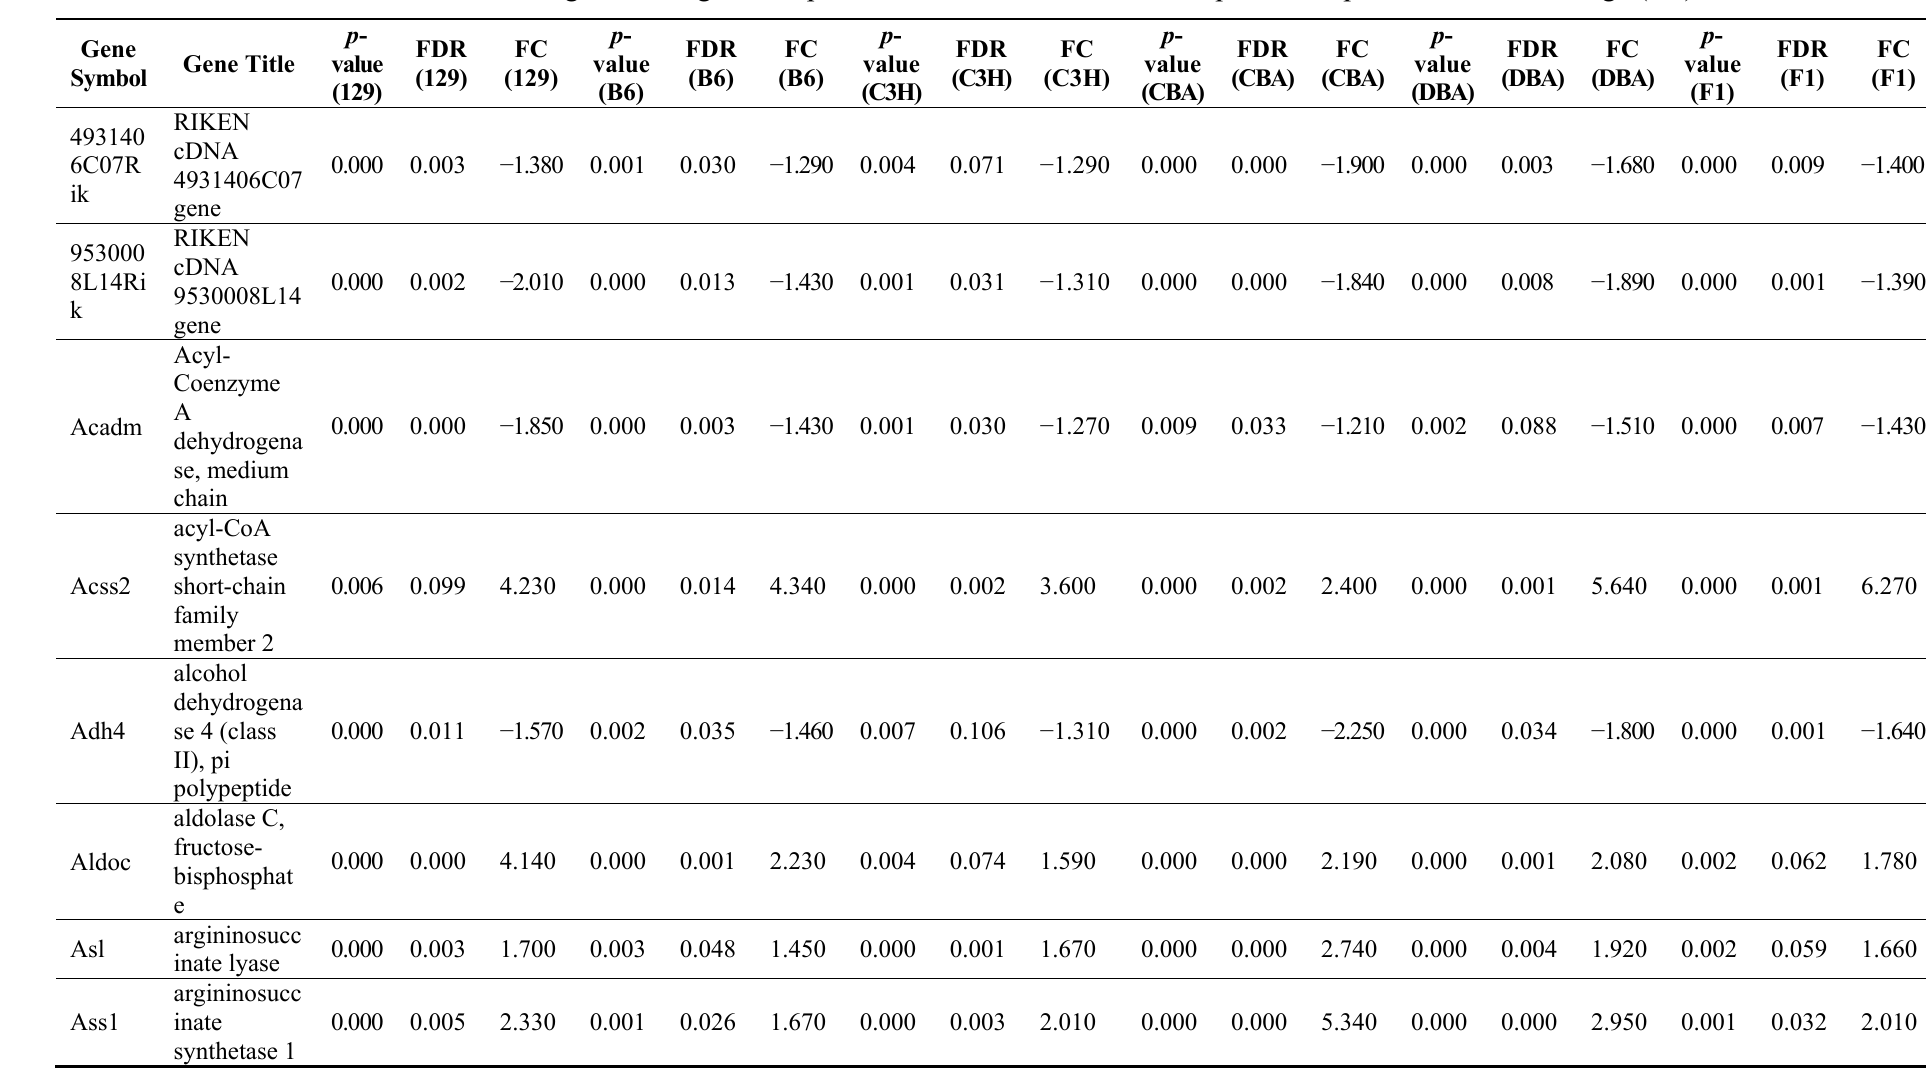
Table A2. Number of genes changed in expression for each strain. Values reported are p value and fold change